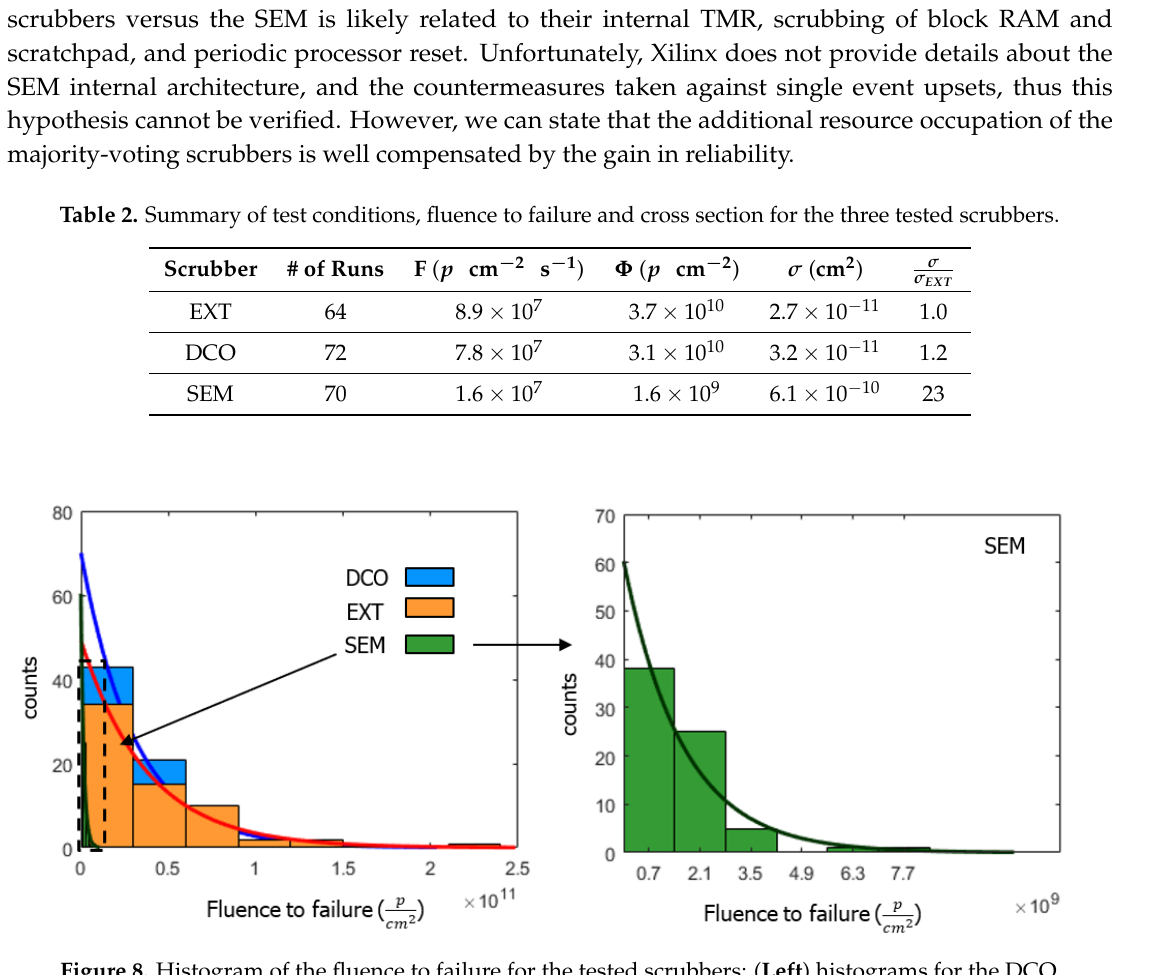
Figure 8. Histogram of the fluence to failure for the tested scrubbers: ( Left ) histograms for the DCO, EXT and SEM scrubbers with superimposed exponential fit curves; and ( Right ) close-up on the SEM histogram and pertaining